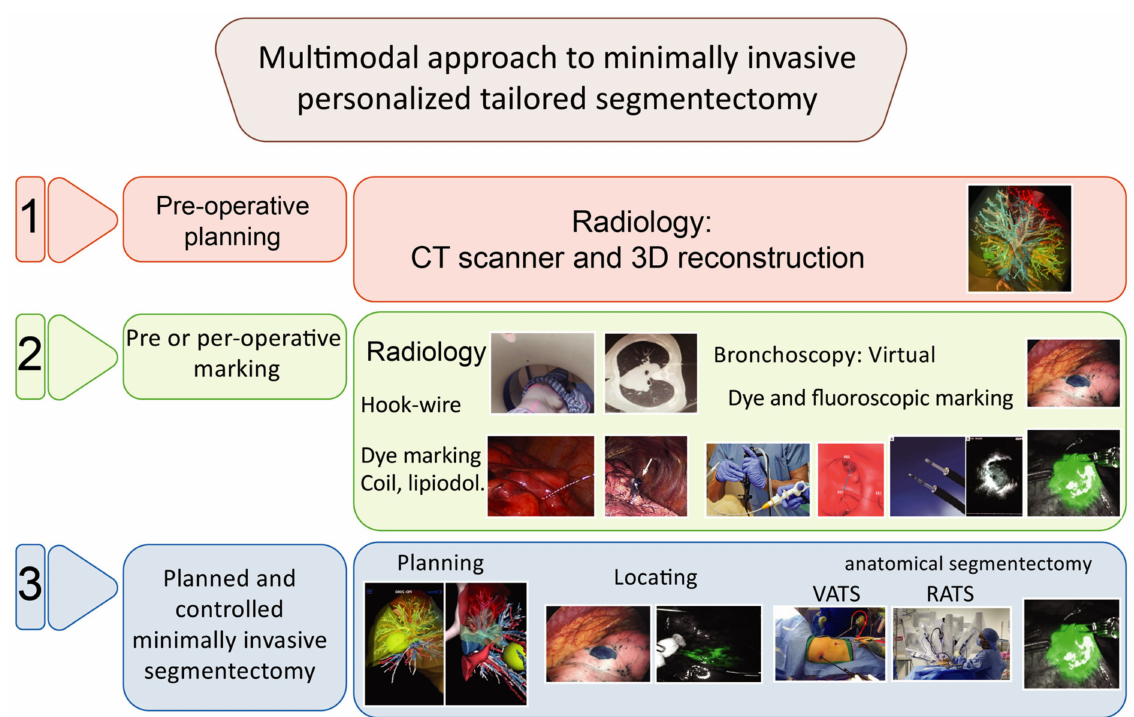
Figure 4. Multimodal approach to minimally invasive personalized tailored segmentectomy. Multimodal approach to minimally invasive personalized tailored segmentectomy in 3 steps. Step 1 : Pre-operative imaging with CT scan and 3D reconstructions in order to identify anatomical variabilities to perform anatomical segmentectomy. Step 2 : Pre or per- operative lung tumor marking by radiological technique combining CT scan mapping, and hook wire, dye marking, lipiodol or coil; or bronchoscopy technique with virtual endoscopy and ultra-thin probes allowing dye marking or fluoroscopic marking with indocyanine green. Step 3 : Planned and controlled minimally invasive segmentectomy with planning validation, guided resection and the identification or the intersegmental plan using fluoroscopic marking during a VATS or a RATS